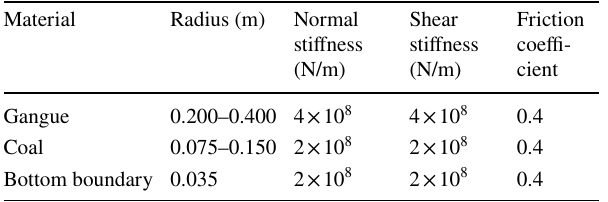
Table 3 Physio-mechanical parameters of coal and gangue particles (Wang et al. 2019) Material